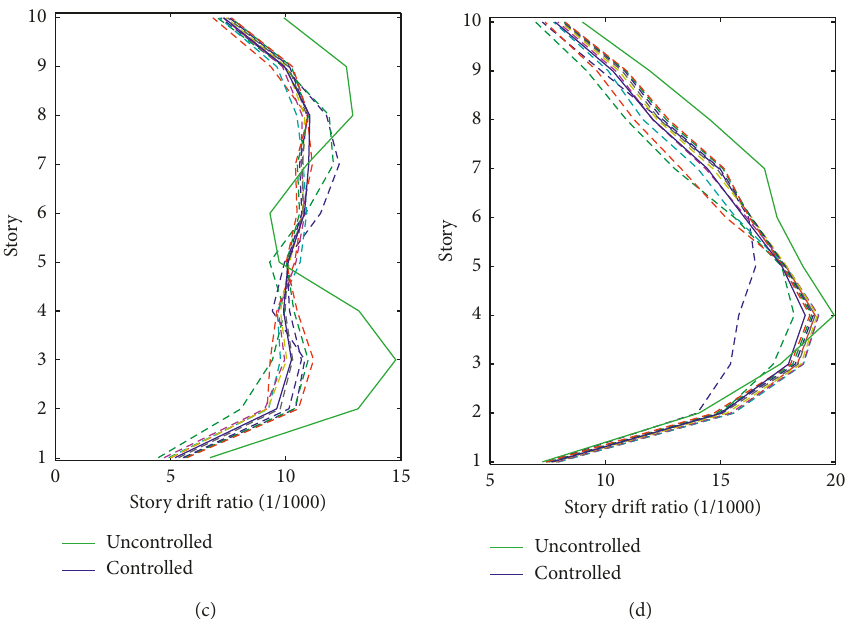
Figure 14: Control effect of structural interstory drift under 0.51g peak value conditions: (a) El Centro; (b) Hachinohe; (c) Kobe; (d) Northridge.